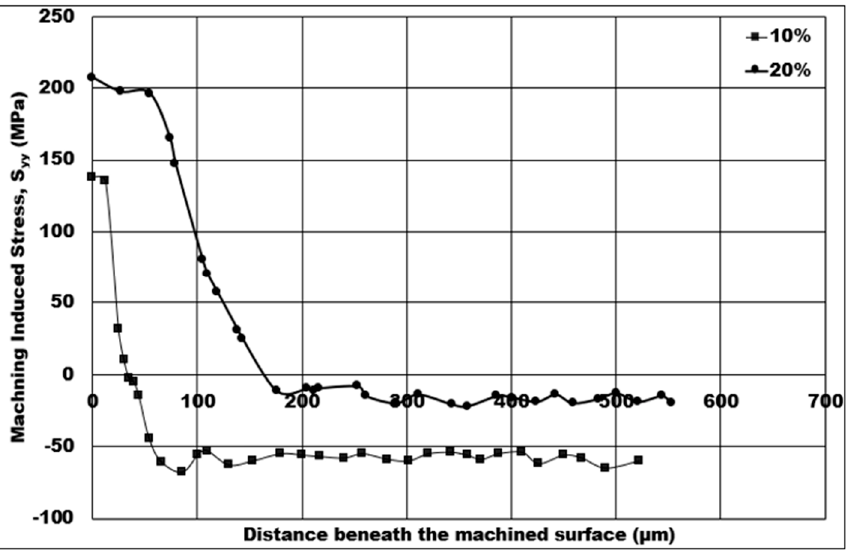
Figure 11. Numerical machining induced stress distribution under the influence of volume fraction of hollow aluminium oxide bubbles (10% volume fraction, cutting speed = 50 m/min, uncut chip thickness = 0.07 mm, average size = 0.3 mm, dry cutting).